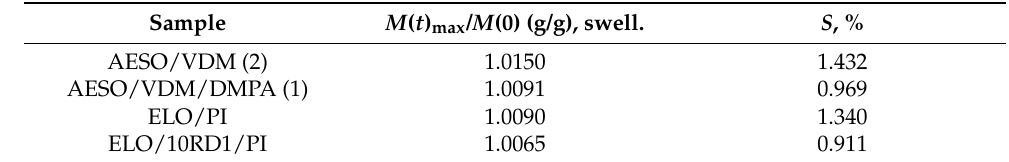
Figure 9. Time dependence of reduced weight M ( t )/ M (0) at swelling experiment for the investigated sam- ples. AESO/VDM squares, AESO/VDM/DMPA triangles, ELO/PI dots, and ELO/10RD1/PI diamonds. Table 2. The Swelling Characteristics of the Investigated Polymer Samples. Numbers in Brackets in Some Cases Mean the Order of Repeated Swelling.